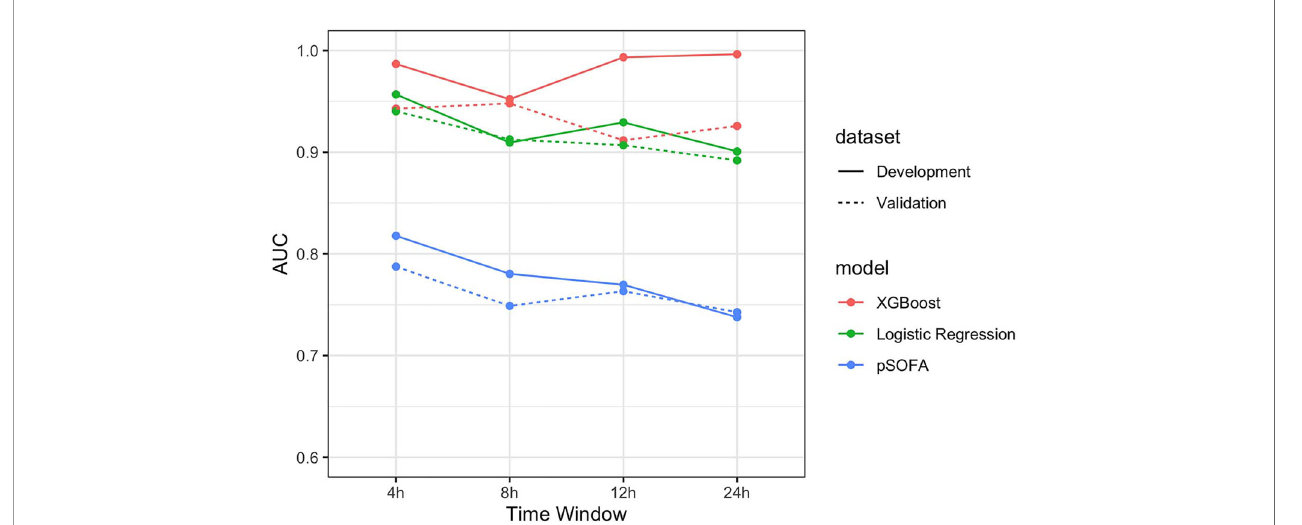
FIGURE 3 | Comparison of AU-ROC between XGBoost, logistic regression, and pSOFA at observation points 4, 8, 12, and 24 h.